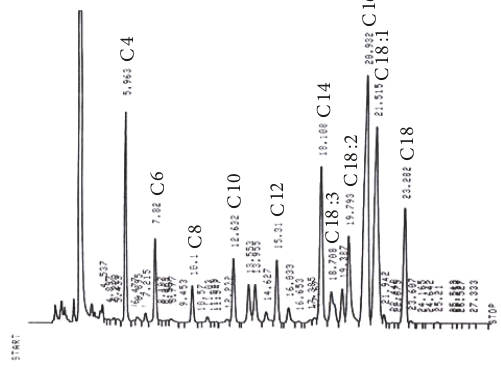
Figure 8: Chromatogram of FA phenethyl esters in butter.